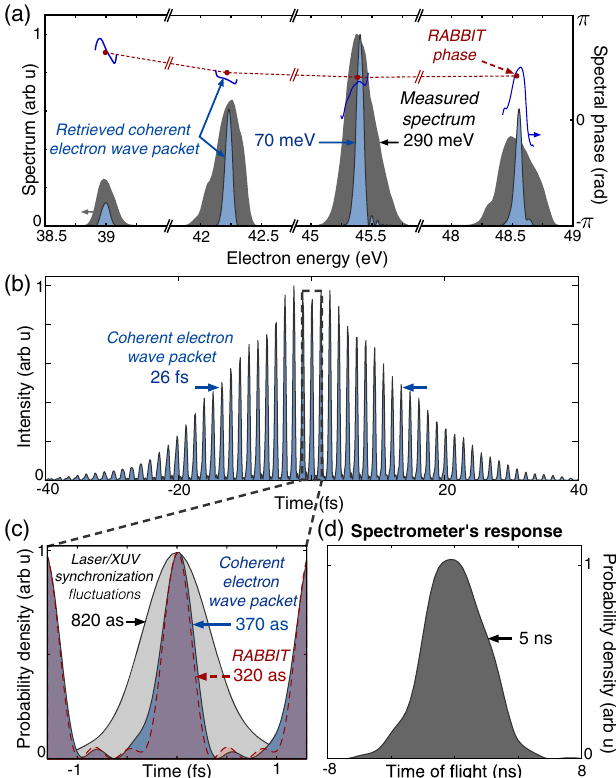
FIG. 4. Parameters of the most probable decoherence scenario. (a) Spectrum (blue shaded curve) and spectral phase (segmented blue line) of the coherent electron wave packet χ 0 free from arrival-time variations and from the spectrometer ’ s influence. The gray shaded curve shows the experimental spectrum also shown in Figs. 2(b) and 2(c). The red dots (connected by a dashed line) stand for the spectral phase obtained with a RABBIT measure- ment in the same experimental conditions except for the dressing laser intensity fixed at 4 . 5 × 10 11 W · cm − 2 . (b) Time profile j χ 0 ð t Þj 2 of the coherent electron wave packet. (c) Envelope P of the fluctuations of the synchronization between the laser and XUV pulses (gray shaded curve) compared with an attosecond pulse composing the coherent electron wave packet χ 0 (blue shaded curve) and the average pulse in the train retrieved with RABBIT (red shaded curve). (d) Response function R of the time-of-flight spectrometer. All widths indicated in the figure correspond to full widths at half